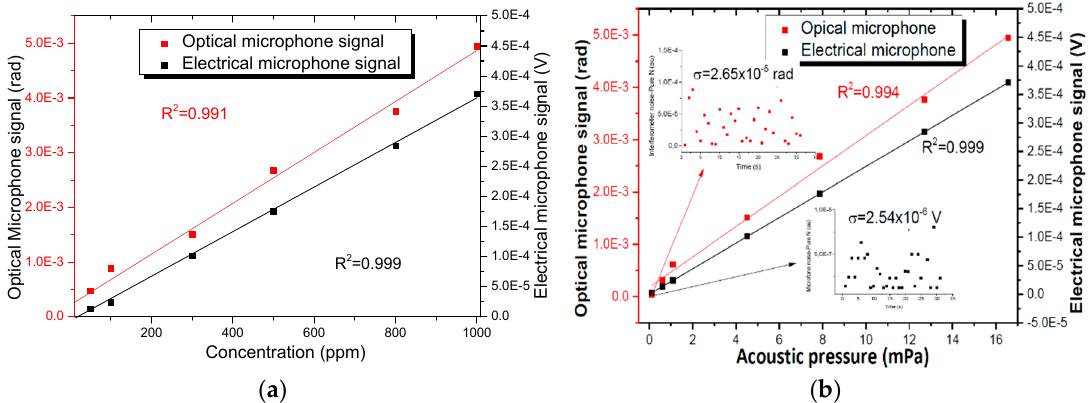
Figure 9. Calibration characteristics and linear fitting. ( a ) The calibration characteristics of the system ranging from 0 ppm to 2000 ppm NH 3 diluted in N 2 . ( b ) The linearity of the two sensors versus the amplitude of the acoustic pressure wave.